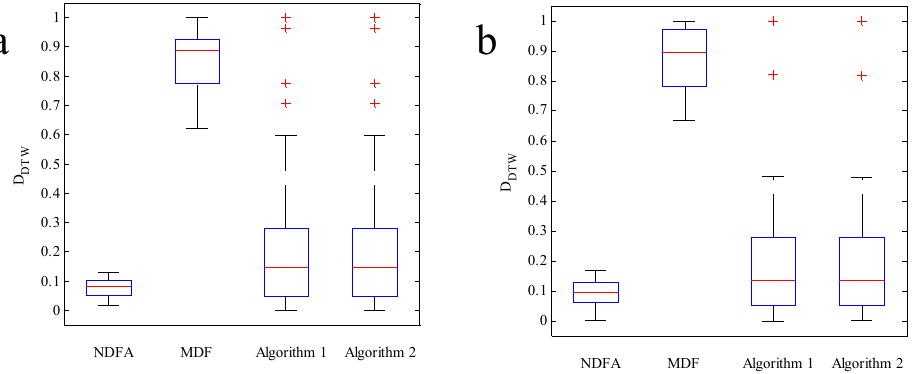
Figure 8. Performance comparison of NDFA, MDF, Algorithms 1 and 2 by DTW. ( a ) Is the comparison for the fused signals by four algorithms and the lead MLII . ( b ) Is the comparison for the fused signals by four algorithms and the lead V5 .